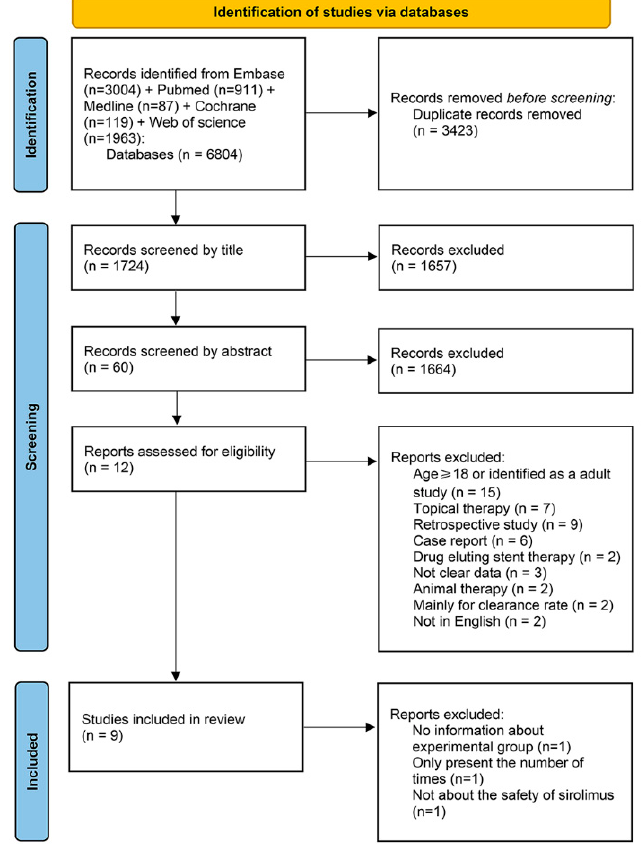
Figure 1. Flow chart of the literature search and study selection. Adapted from Page MJ, McKenzie JE, Bossuyt PM, et al. The PRISMA 2020 statement: an updated guideline for reporting systematic reviews. Bmj. 2021; 372: n71. Table 1. List of studies identified and selected through database searches: demographic